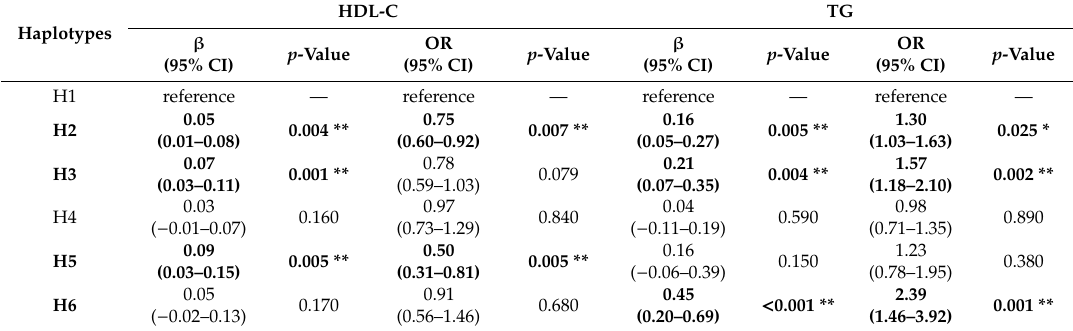
At least nominally significant associations between haplotypes and lipid levels (cut-o ff for HDL-C: < 1.03 mmol / L in male and < 1.29 mmol / L in female; TG: < 1.7 mmol / L in both sexes) are highlighted in bold. * Significant p -value without Bonferroni correction. ** Significant p -values with Bonferroni correction.